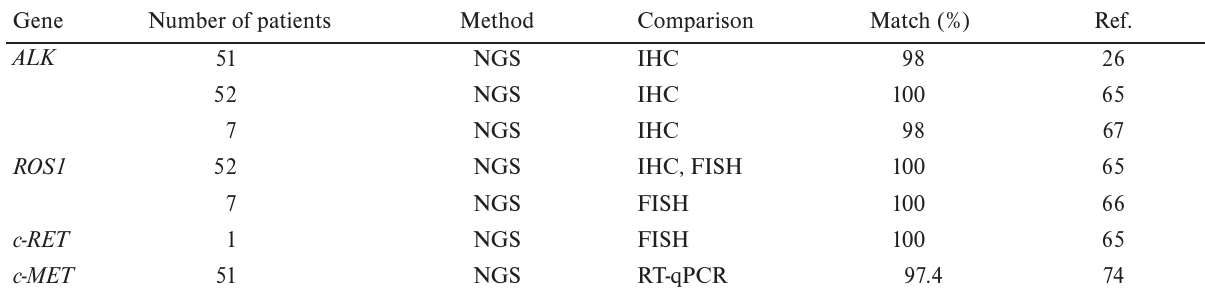
Table 1. Current comparison of NGS with IHC, FISH and RT-qPCR in detection of gene rearrangement in NSCLC. Gene Number of patients Method